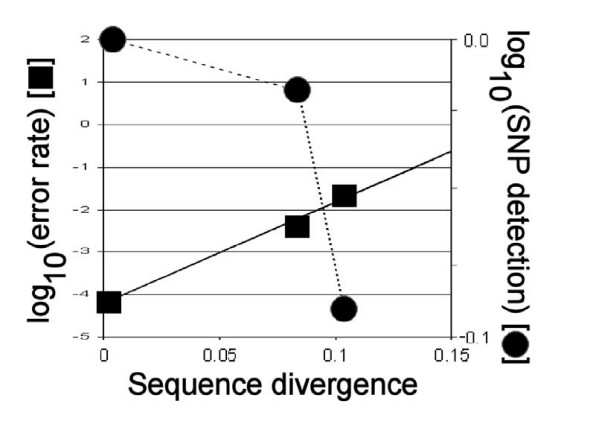
High-confidence error rate (E: squares) and SNP detection rate (circles) versus pairwise sequence divergence (D) for human, chimpanzee, and gorilla mtDNA genomes. The equation of the trend line is log(E) = (19.6)(D) – 3.9.